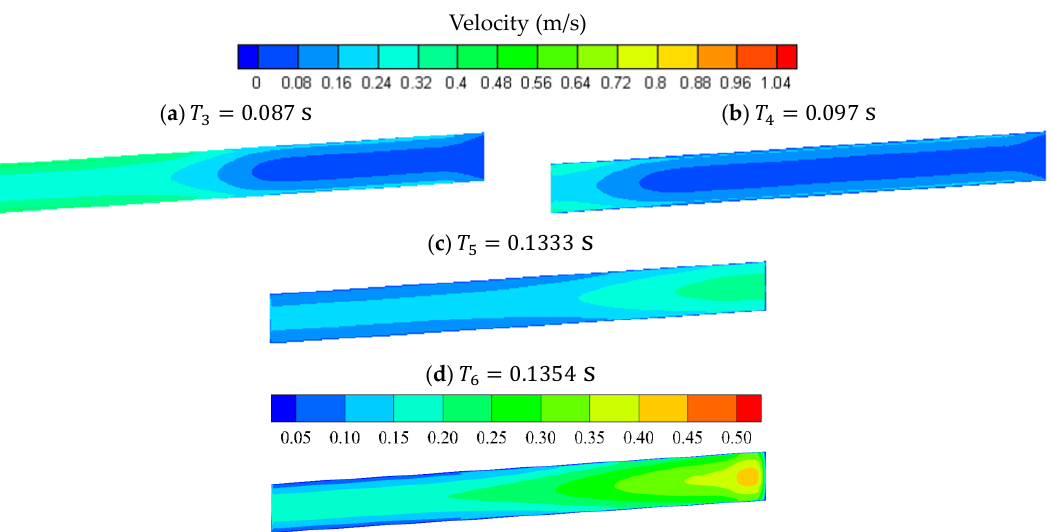
Water 2018 , 10 , x FOR PEER REVIEW Figure 34. Pressure field evolution on the axis plane of the pipeline in the cavity collapse stage.